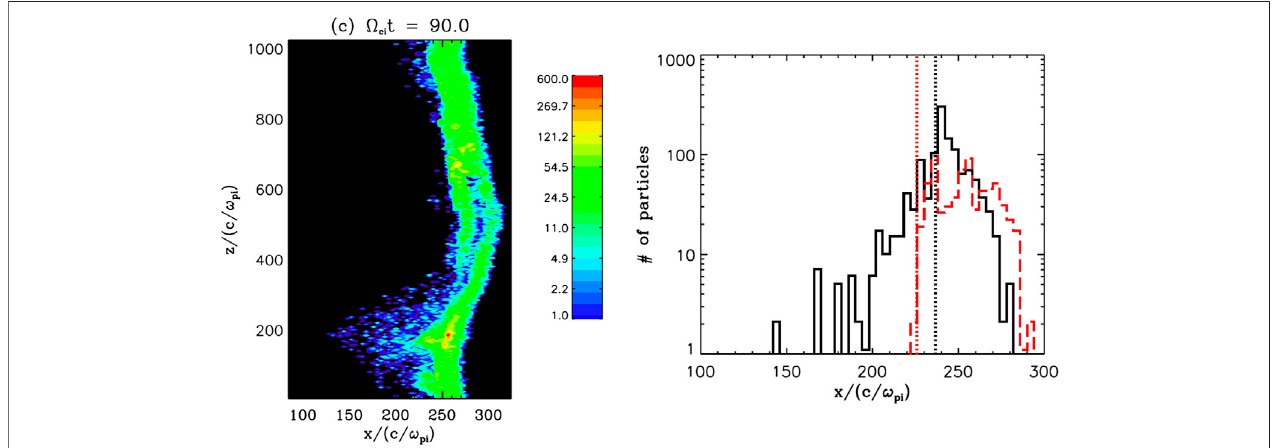
FIGURE6|Left: Numberofenergeticelectronswithenergies E > 10 E 0 intheshockregion,wheretheinjectedelectronenergyis E 0 (cid:1) 100 eV . Right: twopro fi lesat z (cid:1) 200 c / ω pi (black) and at z (cid:1) 800 c / ω pi (red). Adapted from Guo and Giacalone (2010). Reproduced by permission of the AAS.